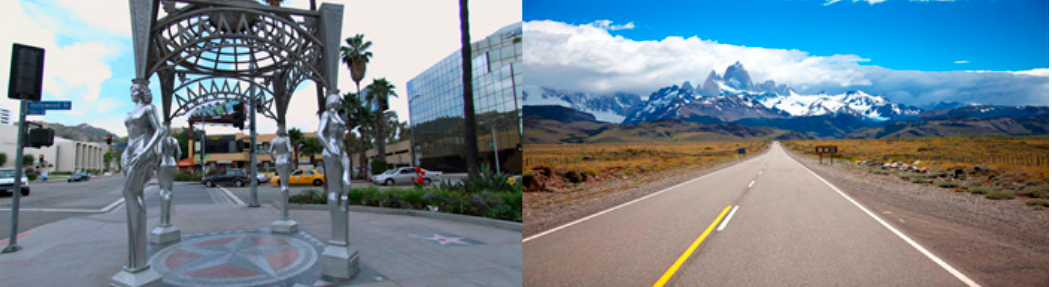
Figure 2. Urban and rural scenes from BitGym© application.